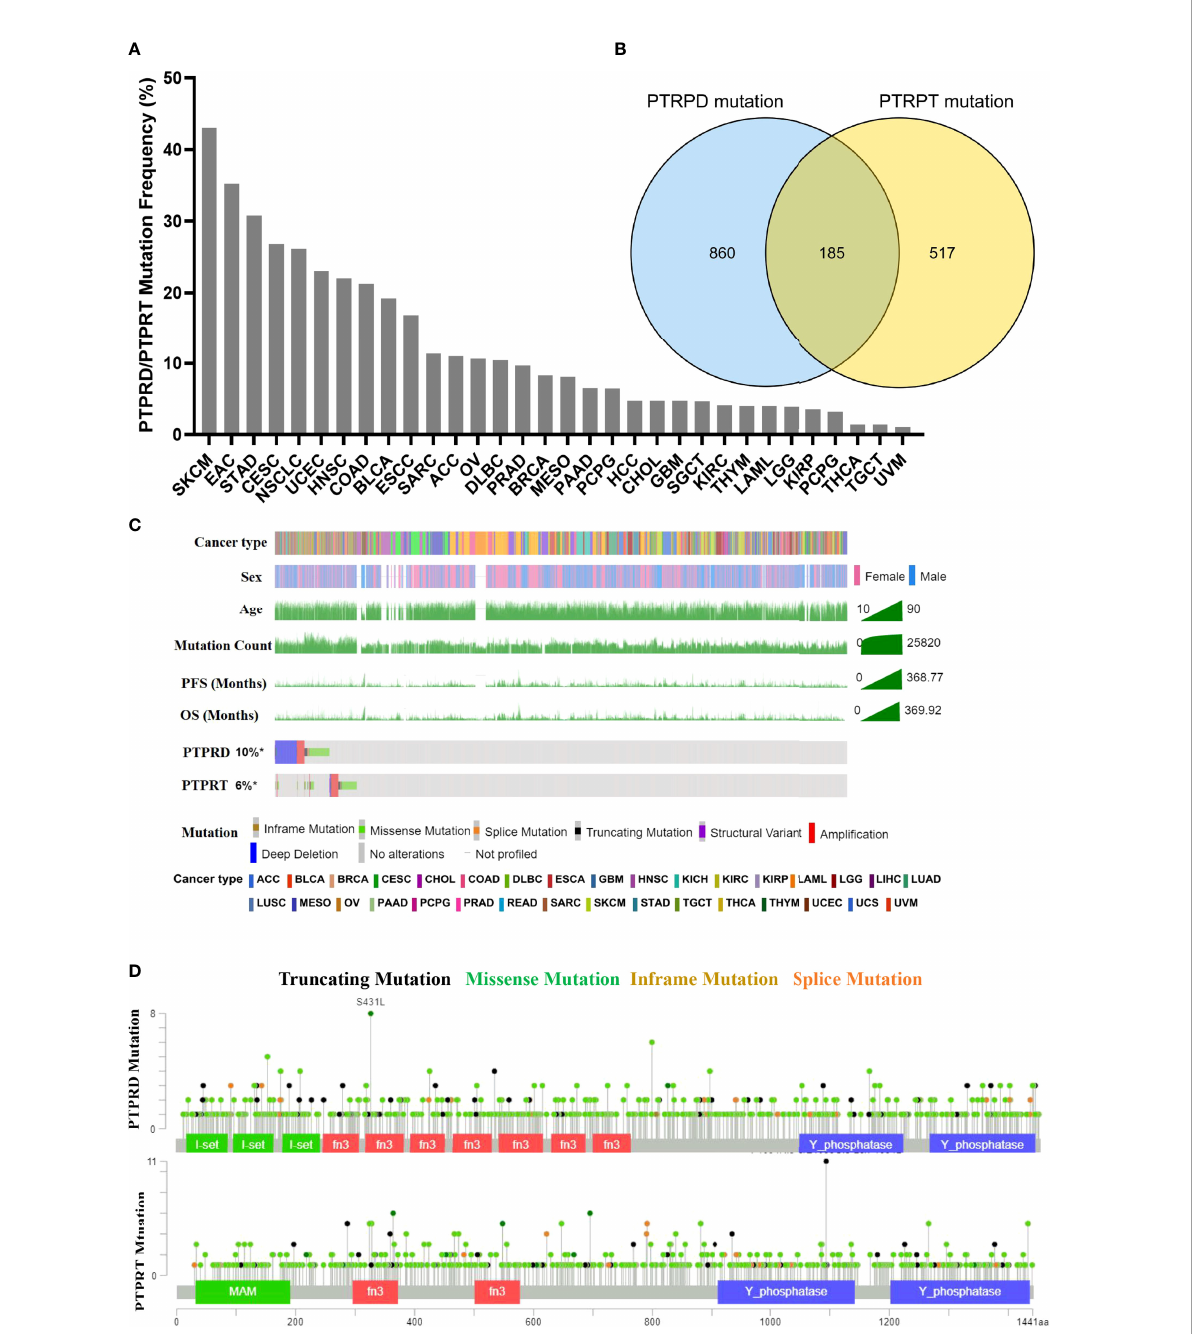
FIGURE 2 Mutational landscape of PTPRD/PTPRT in TCGA pan-cancer cohort. (A) Mutation frequency of PTPRD/PTPRT across tumors. (B) Co-mutation of PTPRD and PTPRT in pan-cancer. (C) The relationship between PTPRD/PTPRT mutations and clinical characteristics, including tumor type, gender, age, PFS and OS. (D) The subtypes and distribution of PTPRD and PTPRT